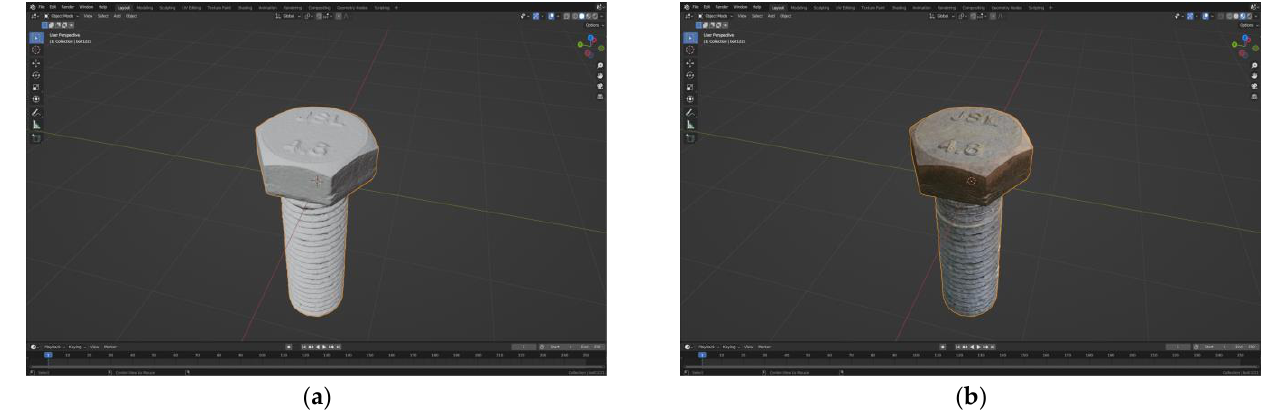
Figure 6. The bolt digital model. ( a ) White model; ( b ) Shading model. (2)